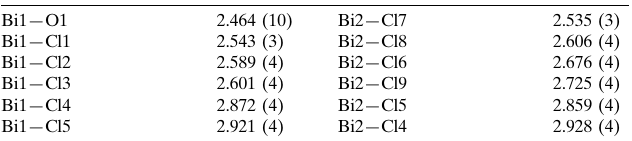
Selected bond lengths (A˚ ).